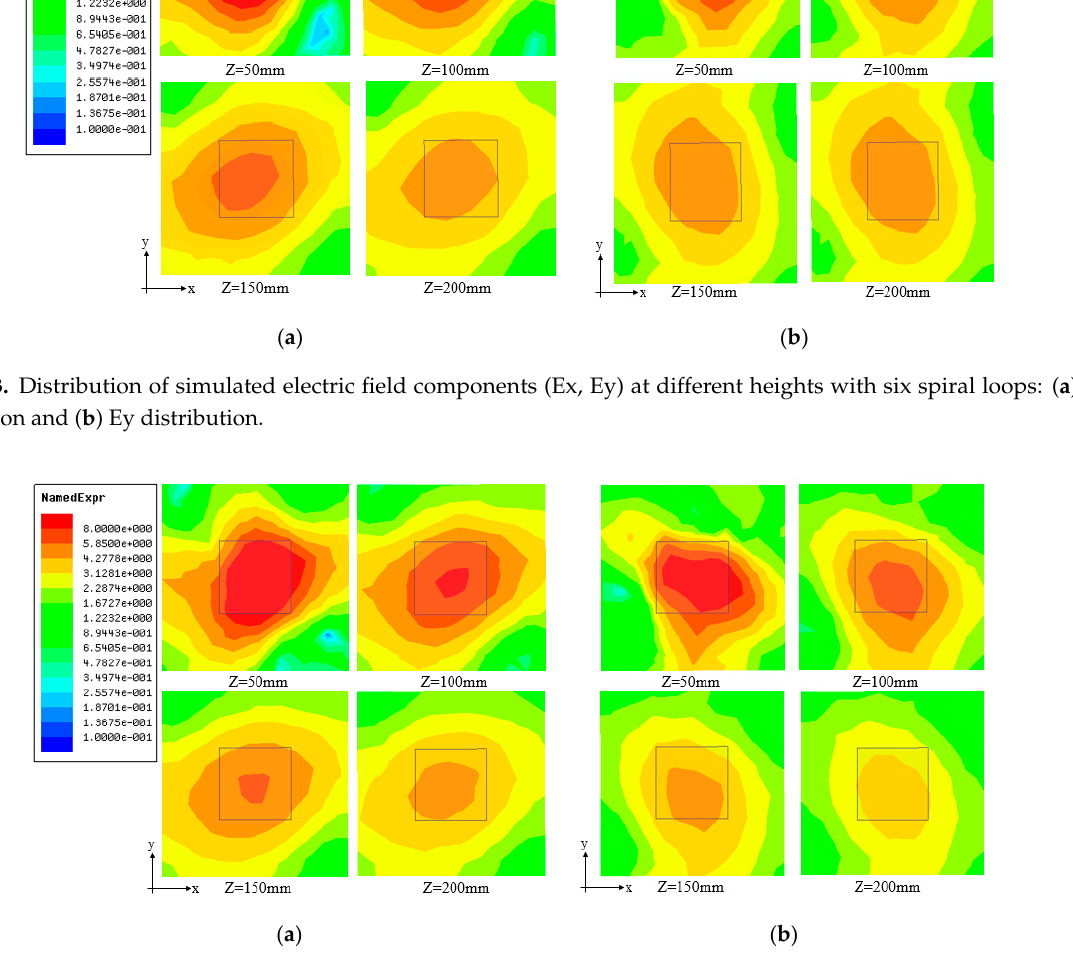
Figure 14. Distribution of simulated electric field components (Ex, Ey) at different heights with seven spiral loops: ( a ) Ex distribution and ( b ) Ey distribution.